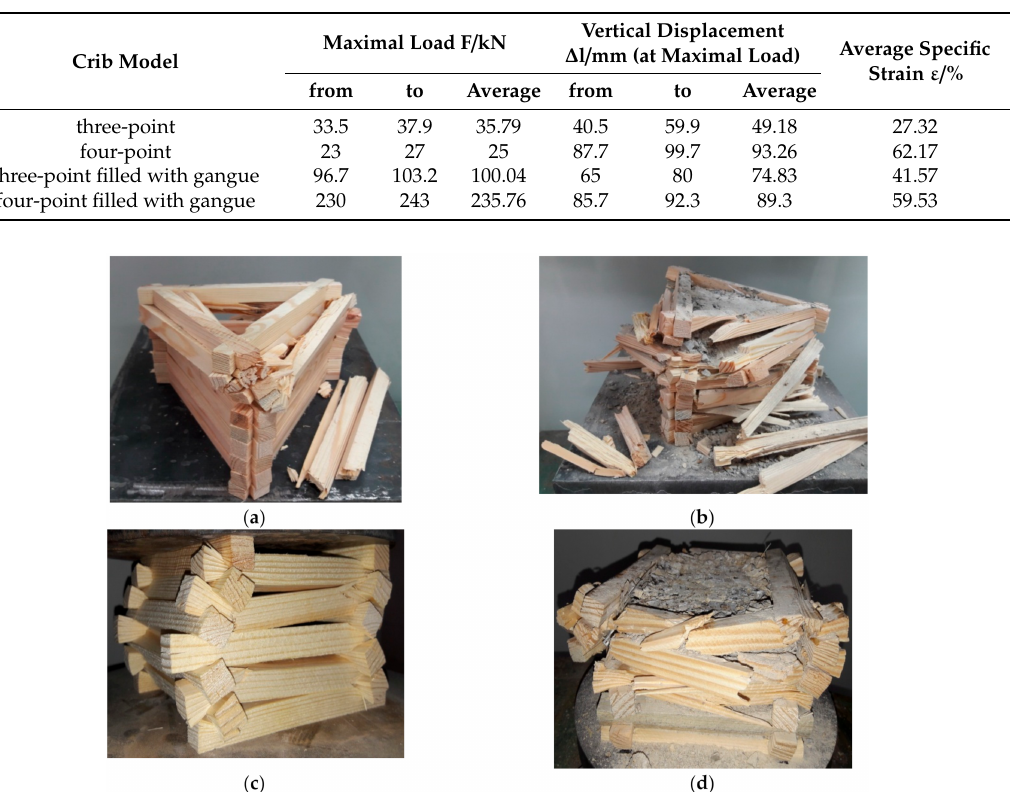
Table 2. Summary of the strength tests.